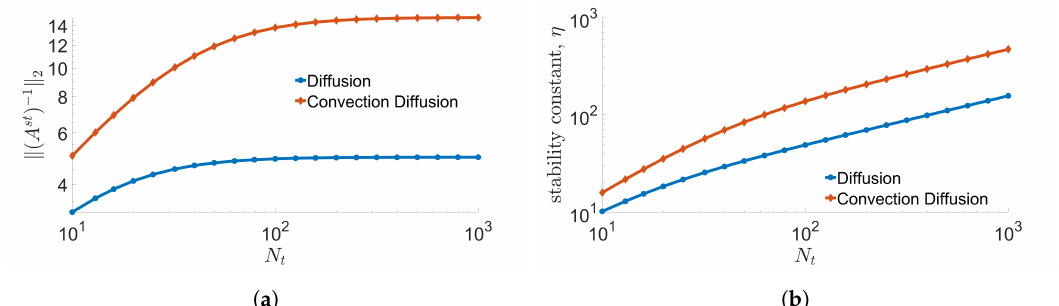
Figure 2. Growth rate of stability constant in Theorem 1. Backward Euler time stepping scheme with uniform time step size, ∆ t = 10 − 2 is used. ( a ): (cid:107) ( A st ) − 1 (cid:107) 2 in inequality (41), ( b ): Stability constant, η in inequality